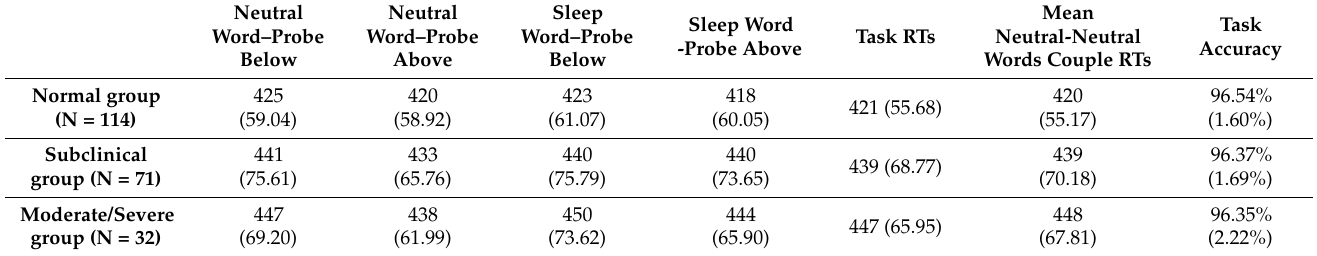
Table 2. Mean RTs (and relative SD), expressed in ms, for detecting the probe appeared above and below the fixation cross in correspondence to neutral or sleep-related words for each sleep group are presented. In addition, the mean (and relative SD) task (general) RTs and neutral-neutral words couple RTs for each sleep group are presented. Finally, the task accuracy for each sleep group is expressed in